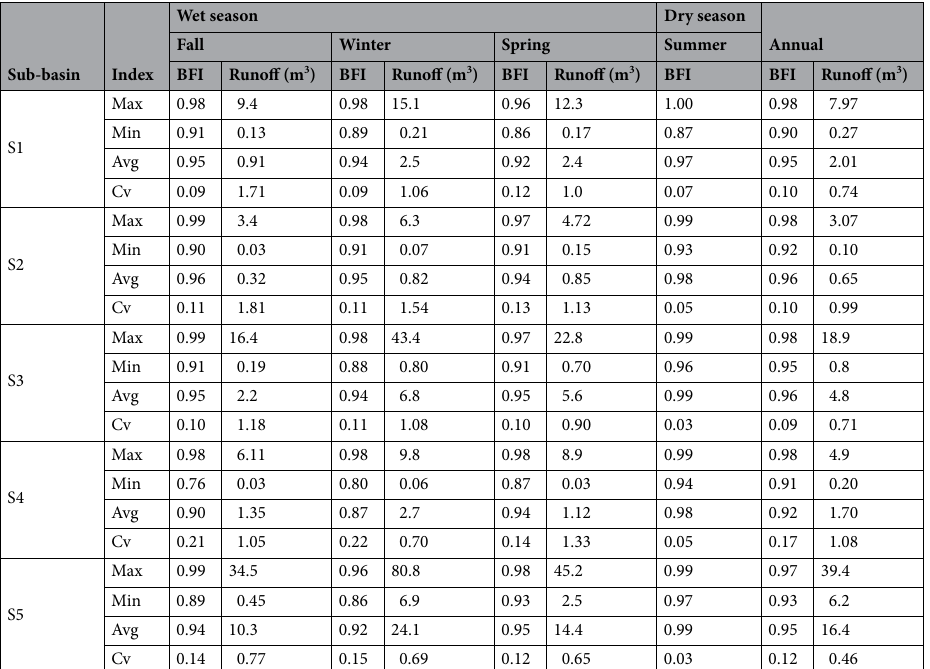
Table 4. Summary statistics characteristics of seasonal and annual separation